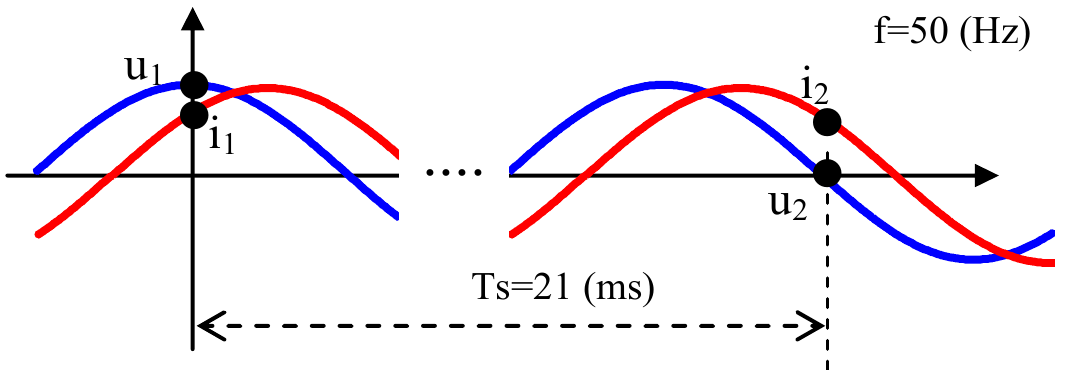
Figure 2. Theoretical (parallel) sampling of voltage and current. This is the equivalent of a 1 kHz sampling rate for stable periodic signals, but requires much less PLC processor power and does not overload its data acquisition system.